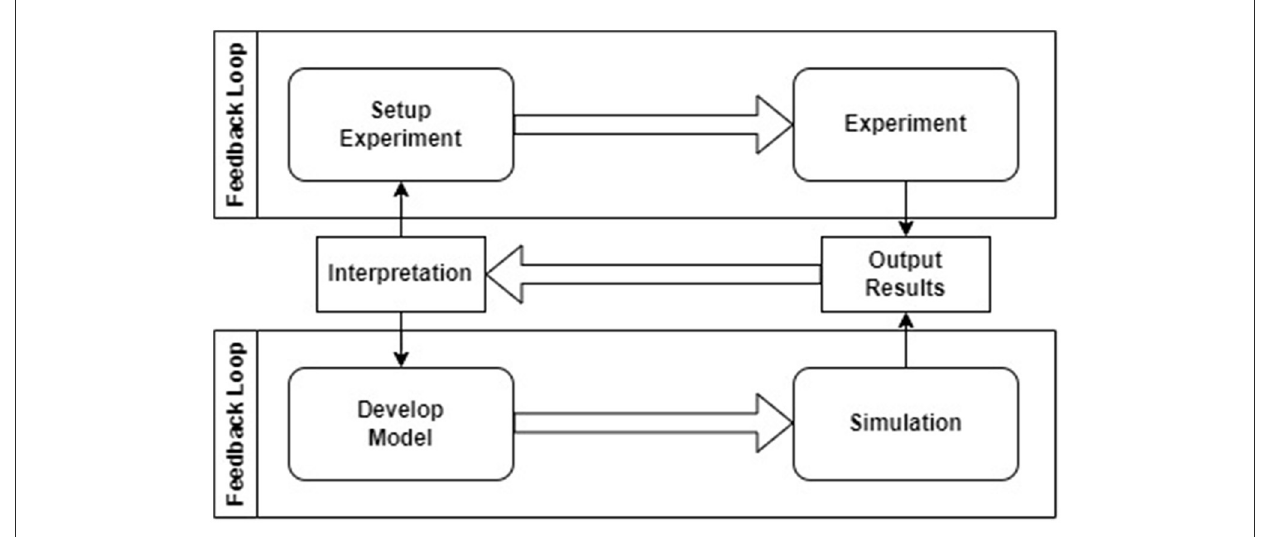
FIGURE1 The relationship between experiment and simulation in computational neuroscience based on GENESIS documentation (Bower et al., 2003).